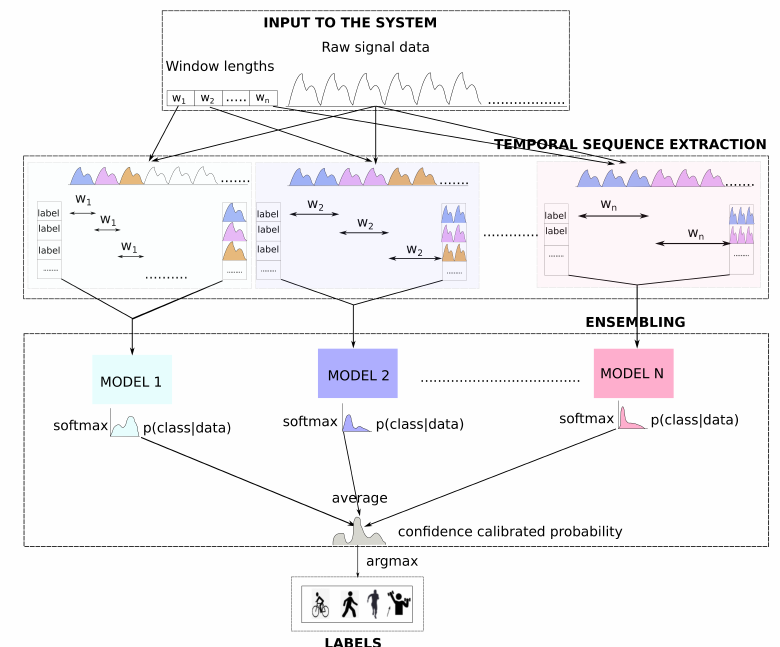
Figure 1. Deep time ensembles: